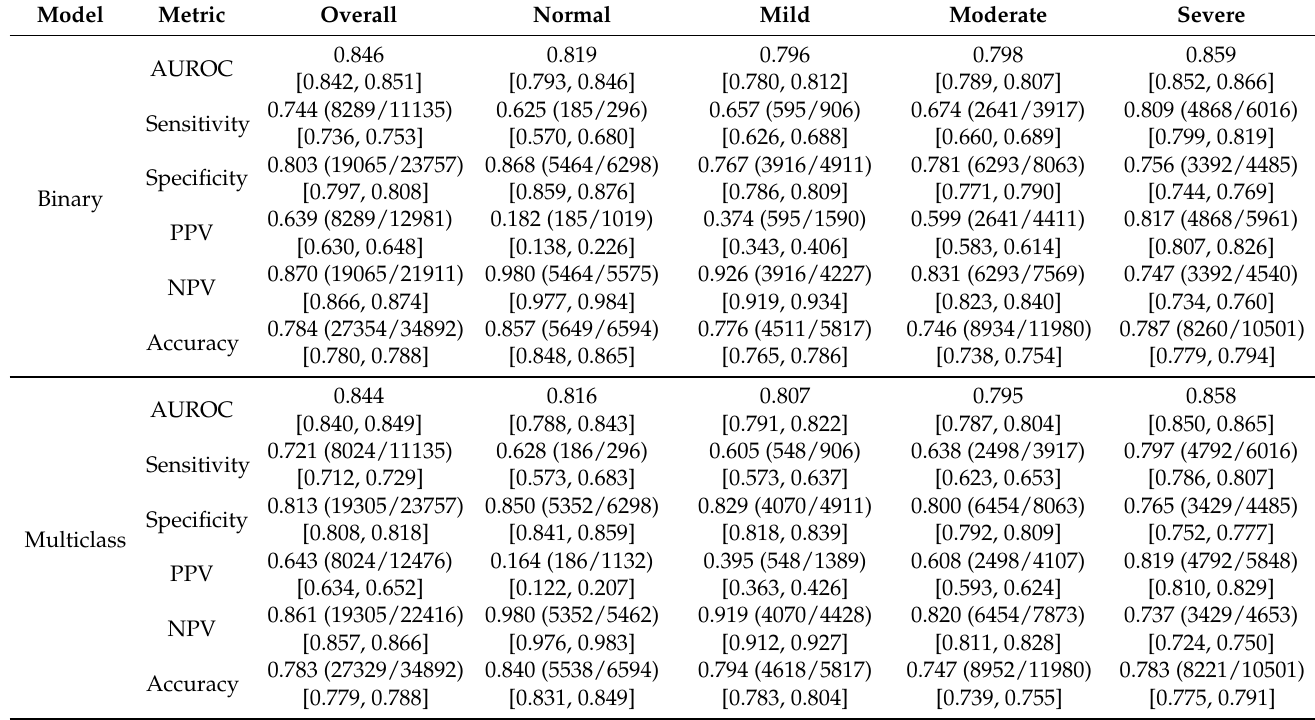
Table 2. Per-segment classification performance in the overall study population and OSA severity groups.